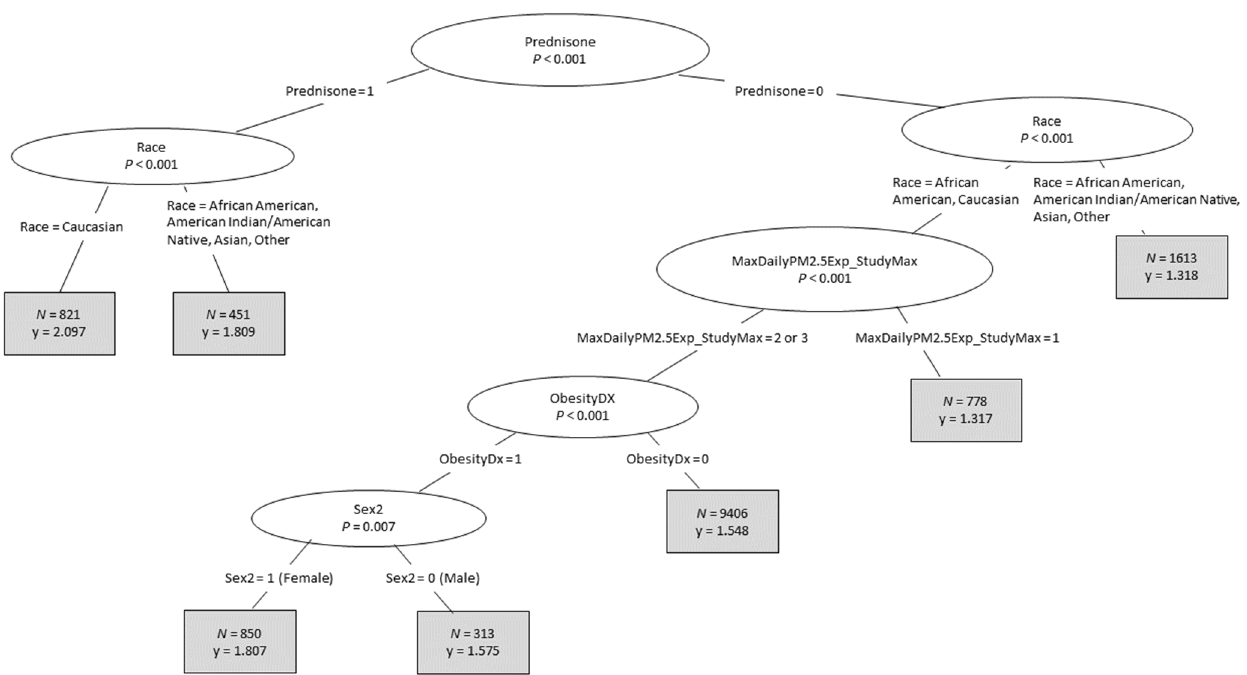
Figure 3. Predictor variable importance and interactions as determined by CTree analysis. The CTree algorithm within Package party in R was applied to the ICEES multivariate dataset (see Figure 1 and Table 1) to confirm the most important predictor variables determined by the CRF analysis in terms of relation to the dependent variable of total annual ED or inpatient visits for respiratory issues and to identify significant interactions between predictor variables. The enumeration levels for each variable are indicated on each branch of the tree. Variables are defined in Table 1.